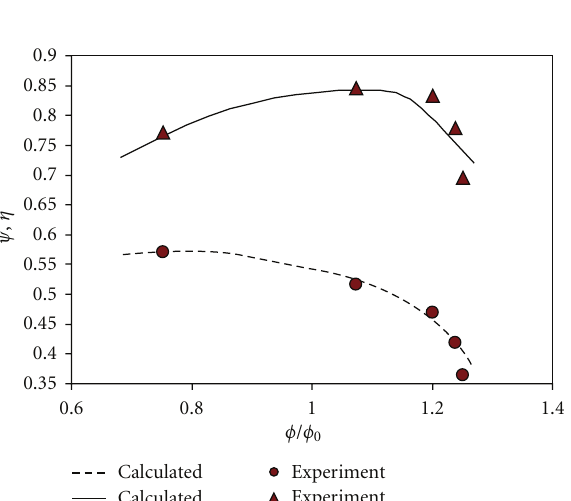
Figure 3: Di ff erent impeller designs.